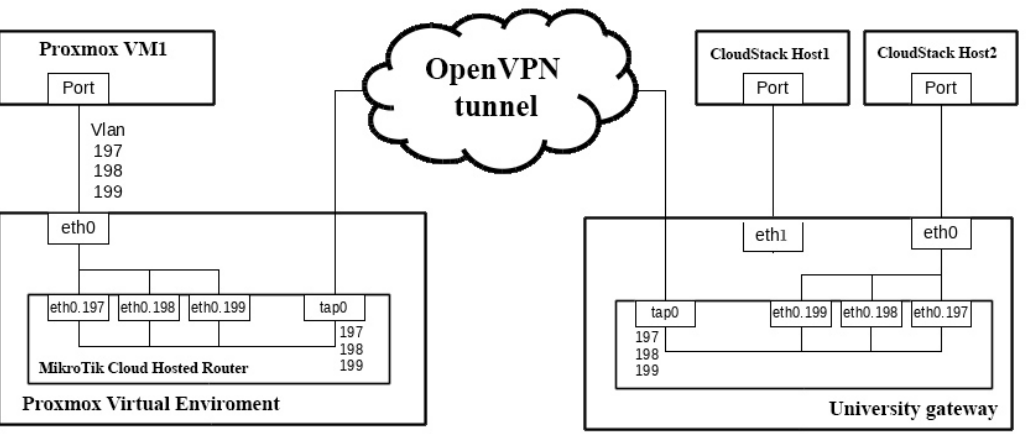
Figure 3: Network integration scheme in CloudStack and Proxmox VE